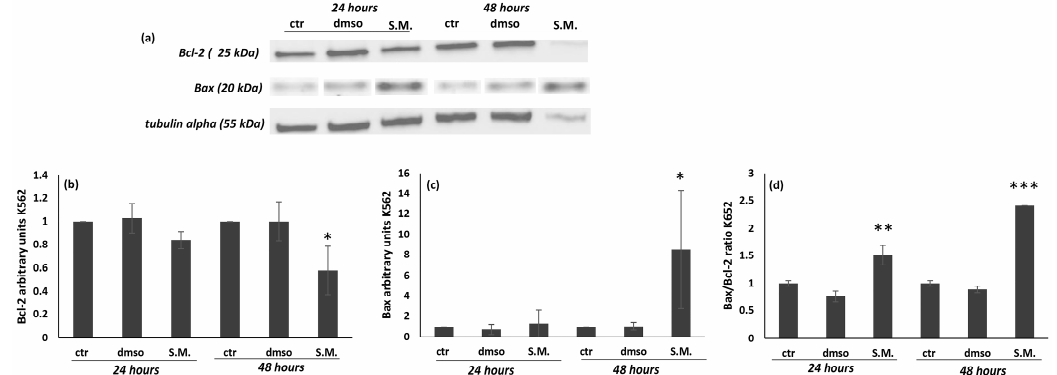
Figure 10. Effect of Skeletonema marinoi (S.M.) (0.75 mg/mL) on Bax and Bcl-2 protein levels in K562 cells after 24 and 48 h of treatment. Panel ( a ): representative Western blot of Bax and Bcl-2; panel ( b ): densitometric analysis of Bax; panel ( c ): densitometric analysis of Bcl-2; and panel ( d ): densitometric analysis of the Bax/Bcl-2 ratio. Experiments were conducted in triplicates, and the values were normalized towards the tubuline. Densitometric analyses were expressed as arbitrary units. Data are shown as mean ± standard deviation (SD) and were compared by ANOVA (* p < 0.05 versus untreated Vero cells; ** p < 0.01 versus untreated Vero cells; *** p < 0.001 versus untreated Vero cells) .